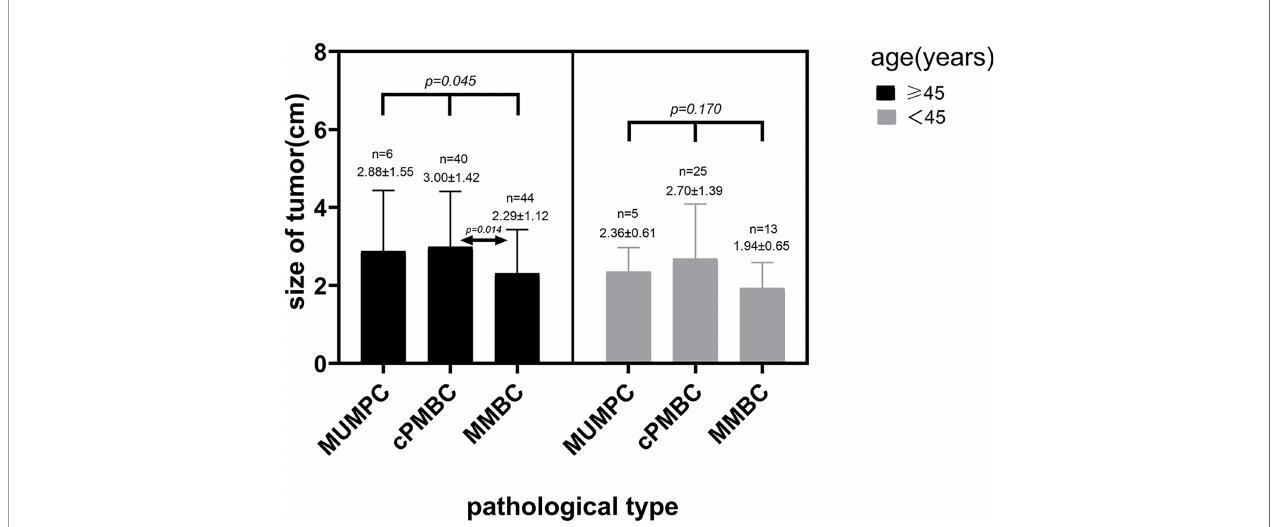
FIGURE 7 | Distribution of tumor size in different pathological subtypes in different age